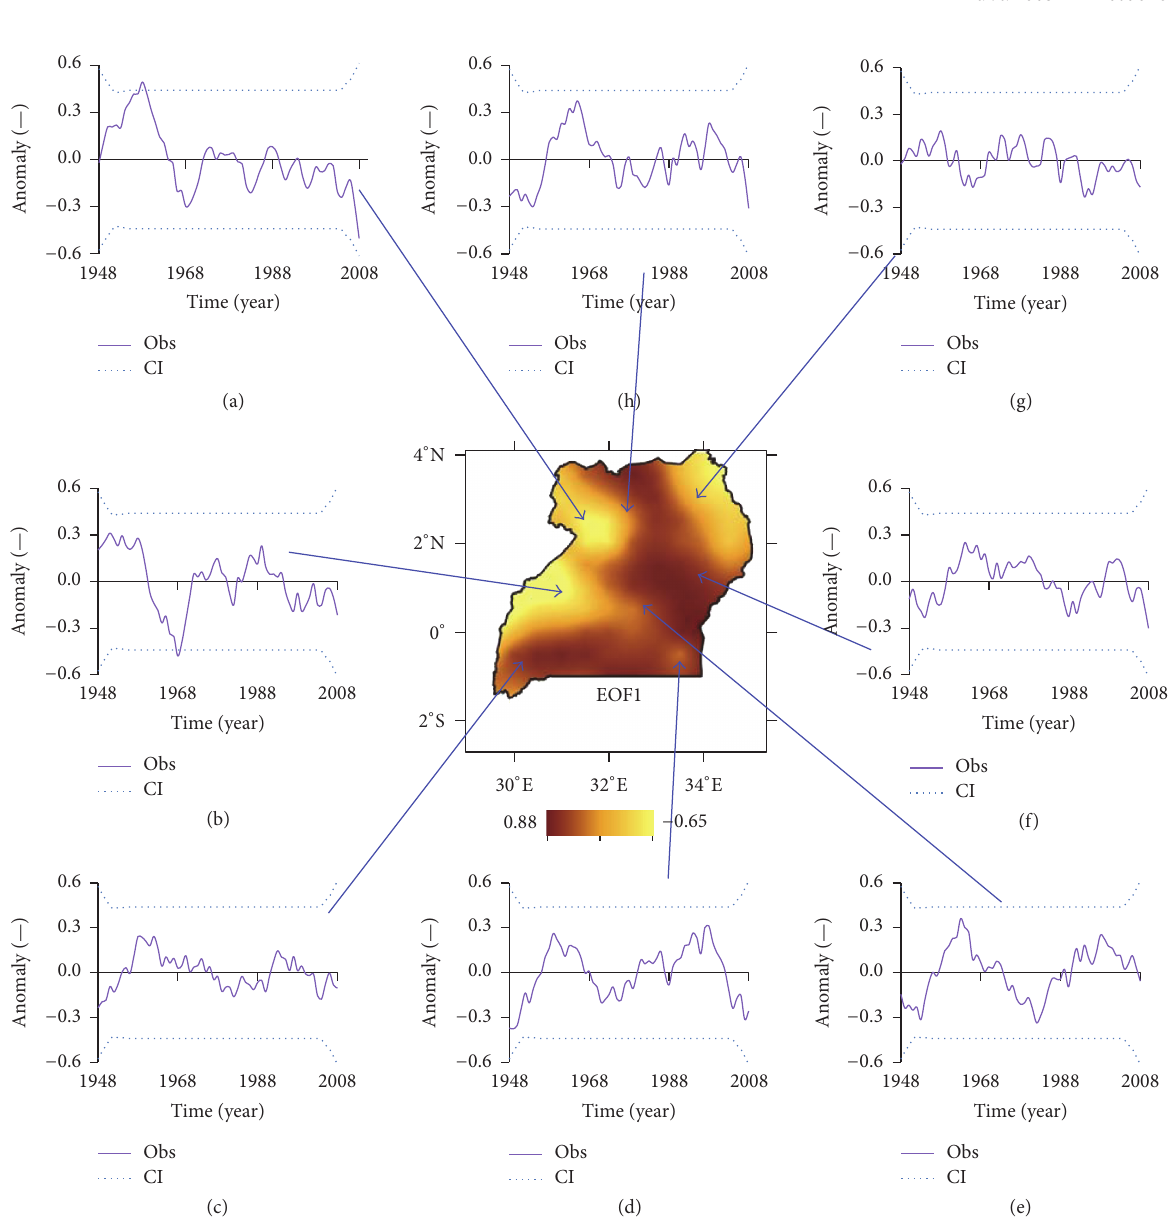
Figure 6: Observed changes (Obs) in the rainfall from (a) to (h) different parts of Uganda based on the spatial variation in the sites for the EOF factor